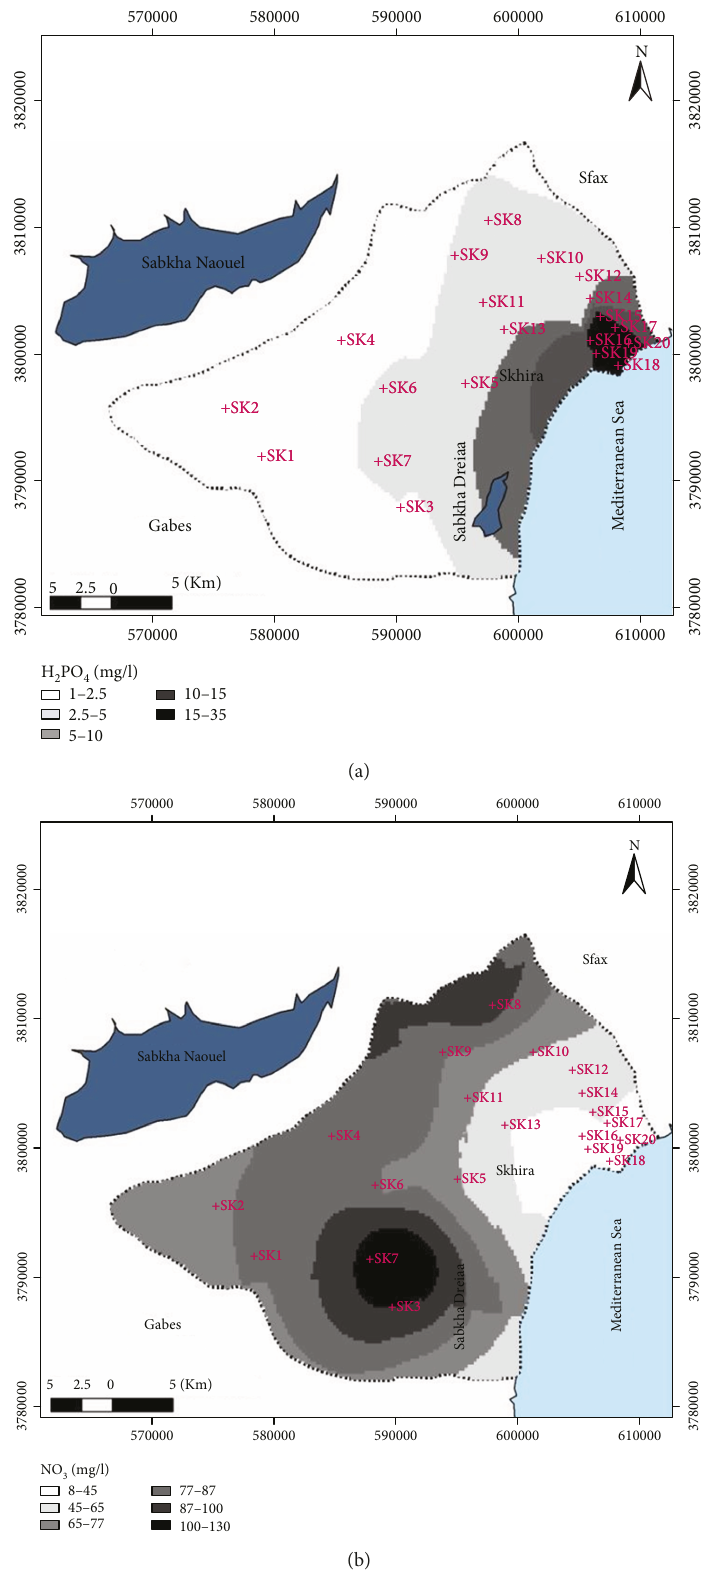
Figure 4: Spatial distribution maps of orthophosphates (a) and nitrates (b) in groundwaters of the Skhira aquifer. See mean error (ME) and root mean square error (RMSE) in Table